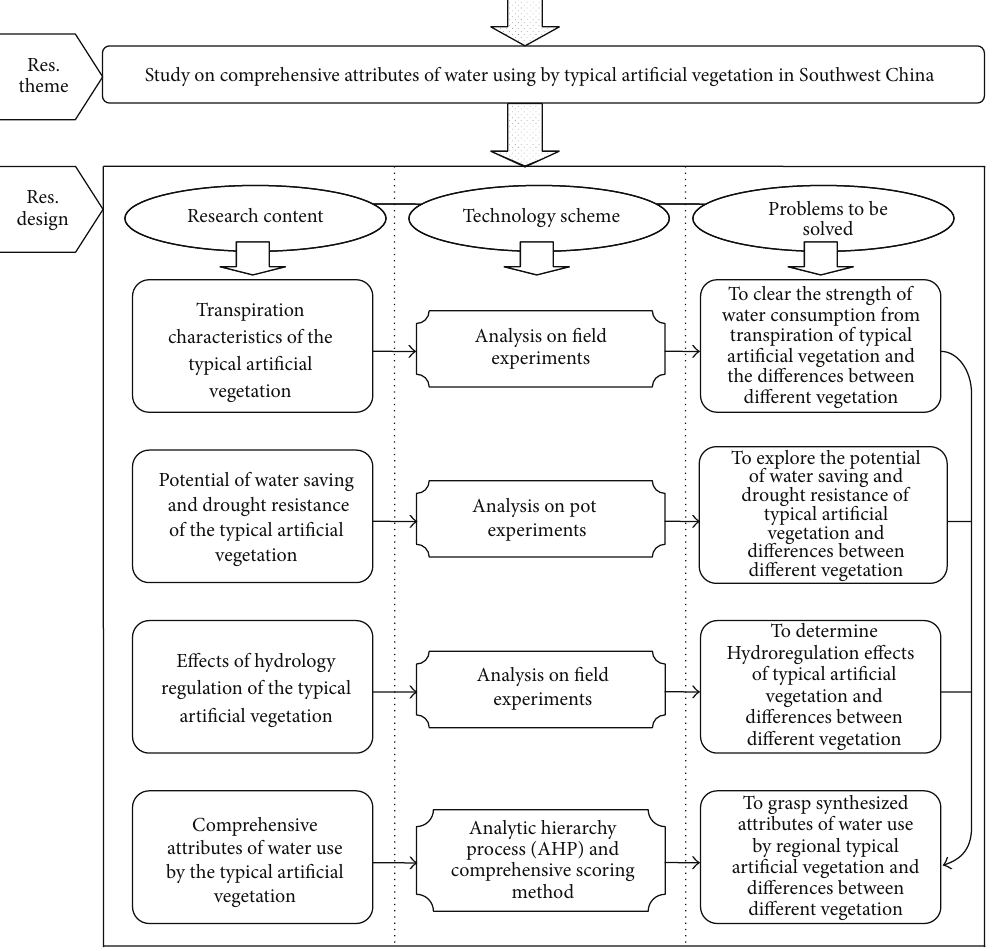
Figure 2: Technical route for synthesized research on water use by regional